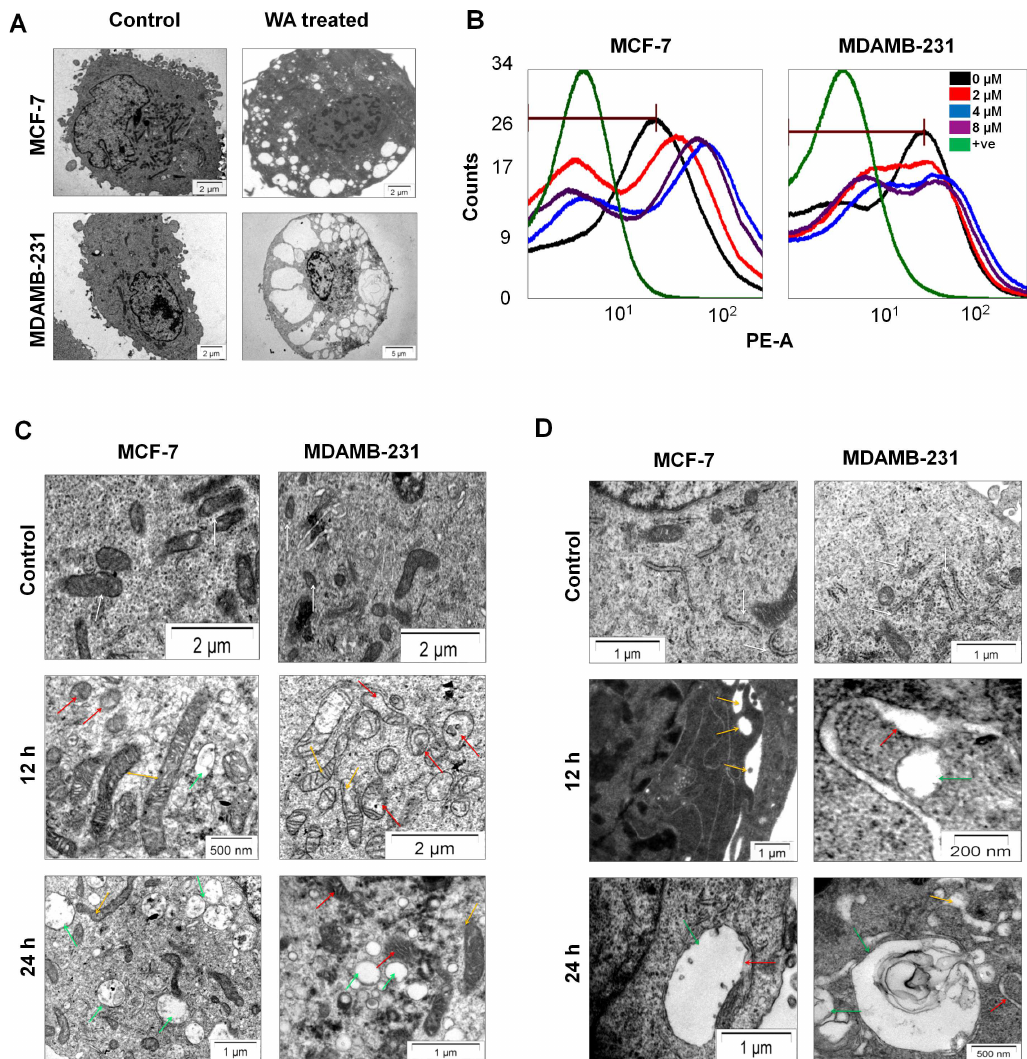
Fig 1. WA induced cytoplasmic vacuolation and altered mitochondrial and ER homeostasis. (A) Transmission electron micrographs of MCF-7 and MDA-MB-231 cells, treated with WA (4 μ M) for 24h showingthe ultra-structural morphologyof extensive cytoplasmic vacuolation. (B) MCF-7 and MDA-MB-231 cells were treated and stainedwith TMRE as describedin method section. The graphsarerepresentative of three individual identicalexperiments showing mitochondrial hyperpolarization by WA treatment, where “0 μ M” represents healthycontrol cells treated with equal amount of vehicle i . e . DMSO only for 24h, and “+ve” represents positive control i . e . cells treated with 10 mM H 2 O 2 for 15 mins for showingmitochondrial depolarization. Both MCF-7 and MDA-MB-231 cells were treated with 0–8 μ M of WA for 24h (sample were preparedas describedin method section). Electron microscopicimages showingthe ultrastructural morphologyof mitochondria (C) ; and ER (D) ; where white, red, yellow and green arrows indicate normal, swelled, enlarged(dilated) and vacuolesrespectively.